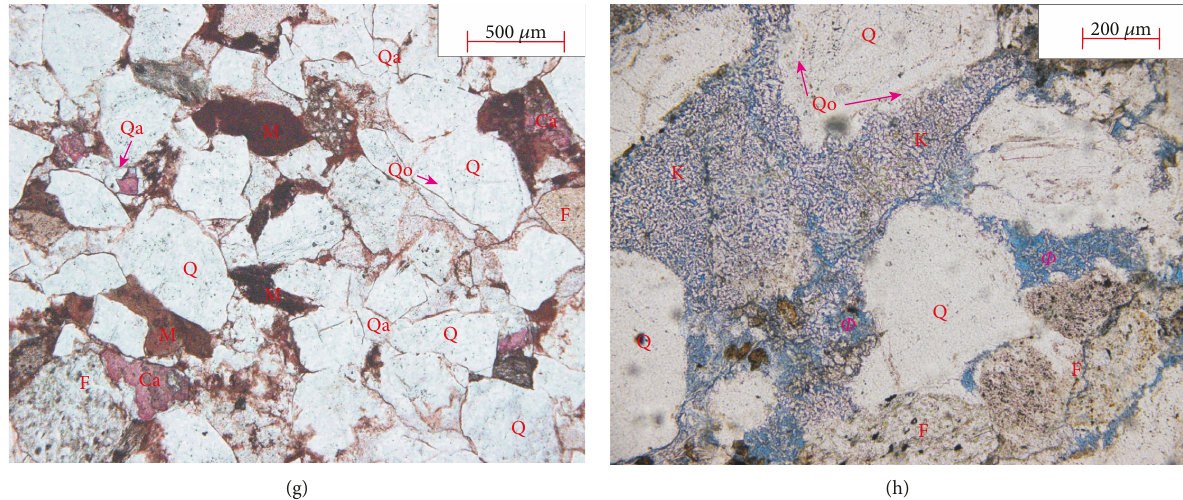
Figure 7: Photomicrographs showing typical minerals and pores of representative samples for each lithologic mode. (a) High content of plastically deformed cuttings, which fi ll in particles after compaction, SD24-55, 2948.97 m. (b) Sandstone rich in rigidly deformed cuttings, and quartz overgrowth and calcite cements can be occasionally seen, SD24-55, 2980.43m. (c) Tightly cemented calcite and well-preserved intergranular pores, part of the quartz developed overgrowth, SD24-55 and 2798.74m. (d) High quartz content with common quartz overgrowth and minor calcite cements, SD24-55, 3014.56m. (e) Calcite crystal stock cementation, Z7, 3025.31m. (f) Chlorite rim can be seen. Authigenic quartz is generally developed in intergranular pores, with minor dissolved pores, SD24-55, 2974.32m. (g) Low matrix content. Quartz developed overgrowth. Ferrocalcite was tightly cemented during the late stage of diagenesis, Z7, 2914.82m. (h) Chlorite is weakly cemented, and dissolution occurred. Intergranular pores and kaolinite intercrystalline pores formed due to feldspar dissolution, Z10, 3108.926 m (Q=quartz; F=feldspar; Cln=chalcedony; Qa =authigenic quartz; Qo=quartz overgrowth; M =matrix; Ca =carbonate cementation; Cln=chalcedony; K=kaolinite; Ms =muscovite; Mqs =mica quartz schist rock debris; Sp =sericite phyllite rock debris; Ph =phyllite rock debris; Slt =siltstone rock debris; Qte =quartzite rock debris; Mqr =mica quartzite rock debris; φ =pore).